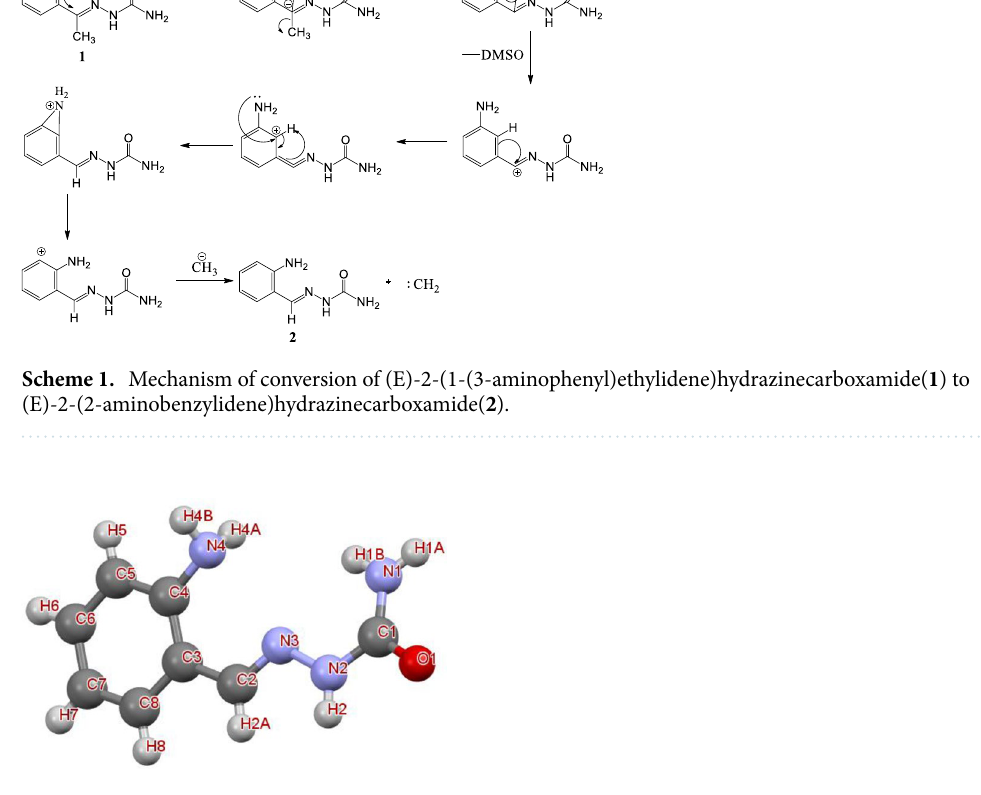
Figure 1. Structure of molecule 2 with labeling of